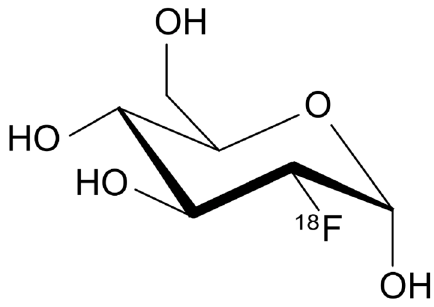
Figure 1. Chemical structure of 18 F-FDG.